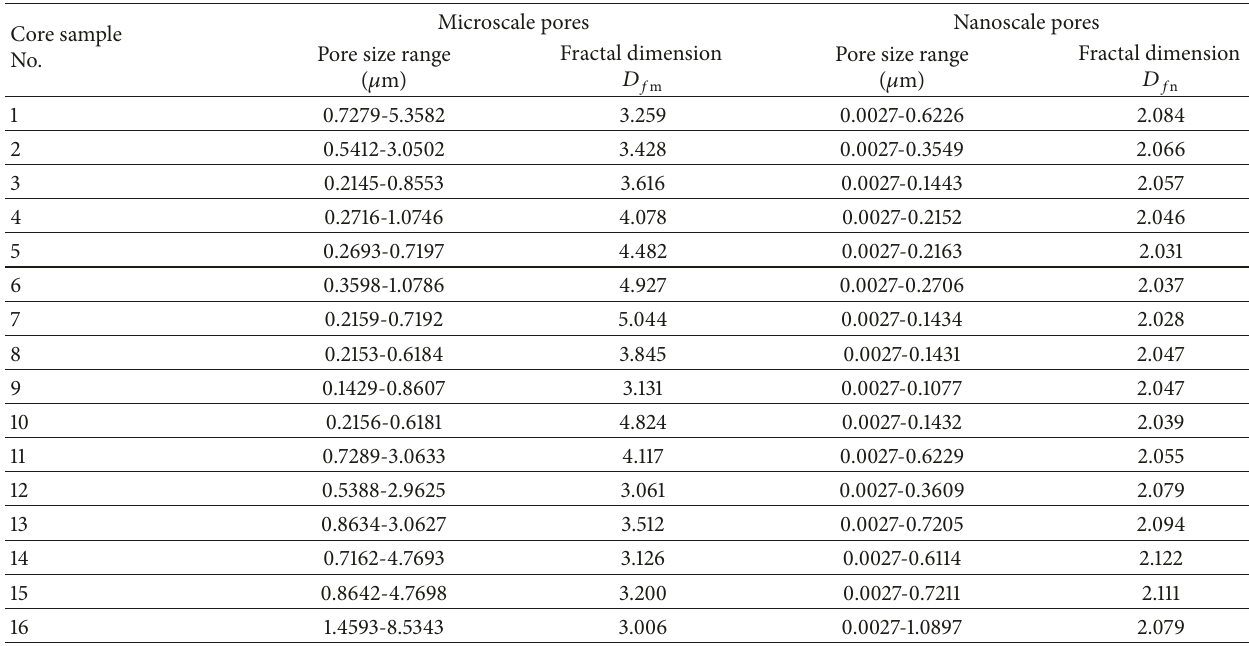
Table 4: The fractal dimensions of microscale pores and nanoscale pores calculated with method II using two-straight-line fitting. Core